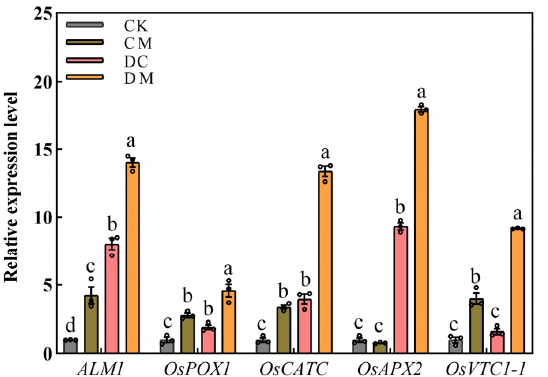
Figure 7. Effect of melatonin on antioxidant system-related gene expression levels under drought stress.